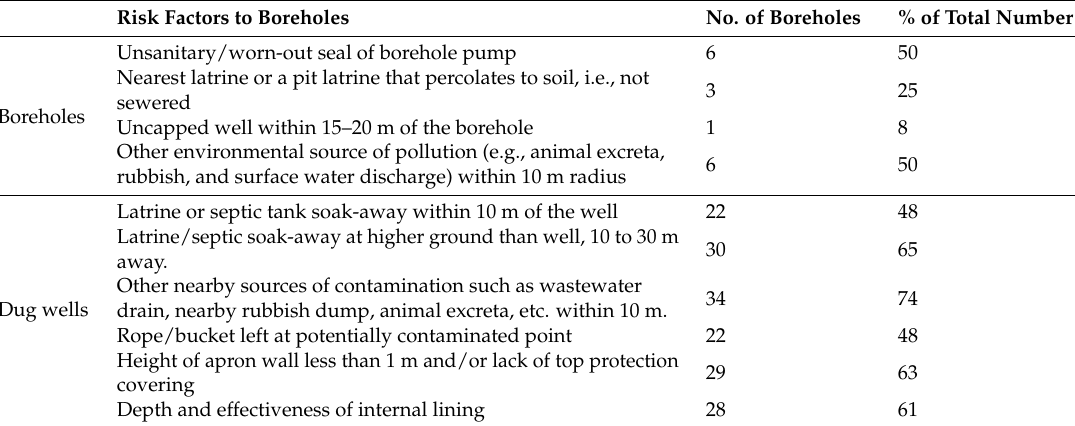
Contamination risk factors of boreholes (total 12) and dug wells (total 46) by contamination